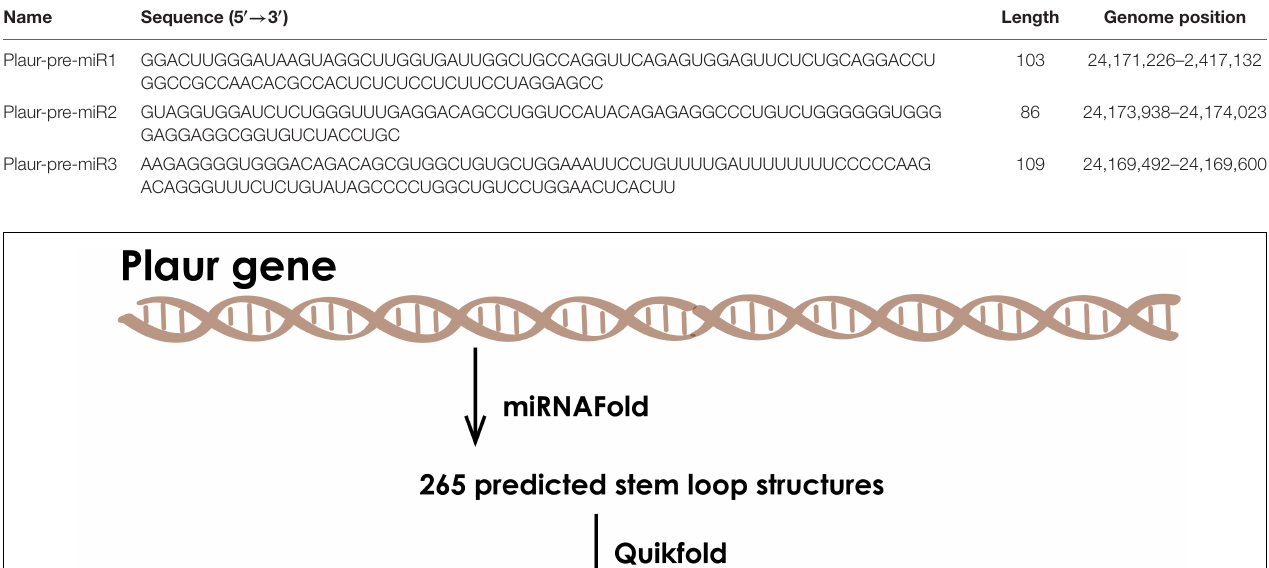
TABLE 1 | Selected precursor miRNAs encoded in the Mus musculus Plaur gene.